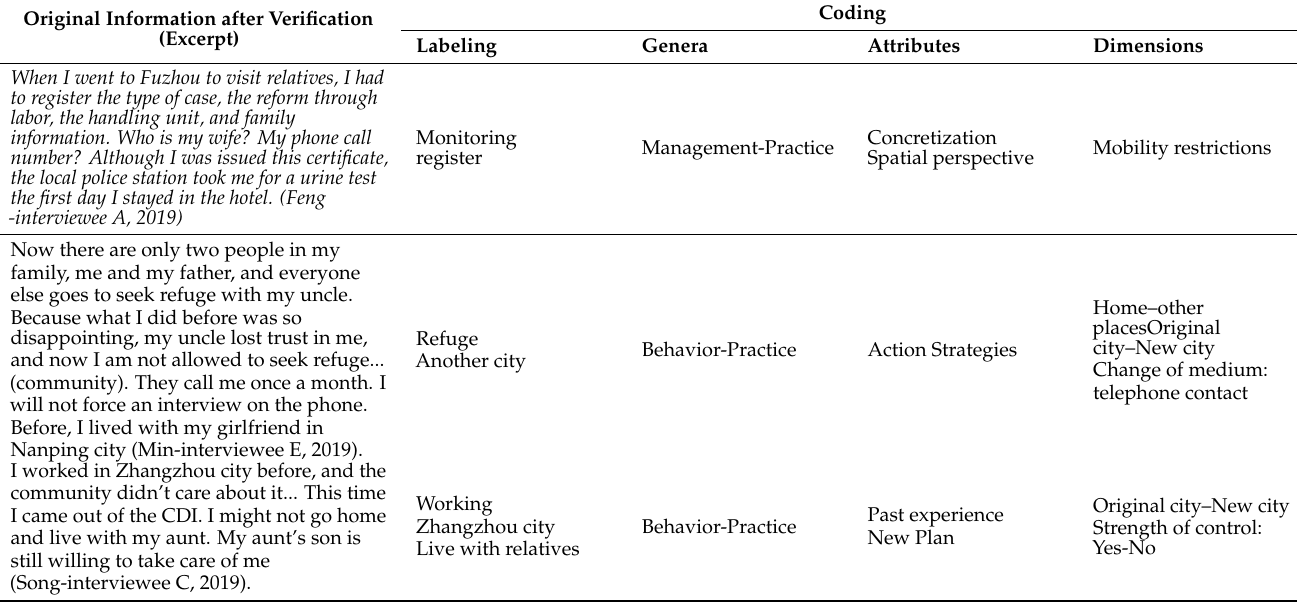
Table A2. The process of coding the interviewees’ partial interview